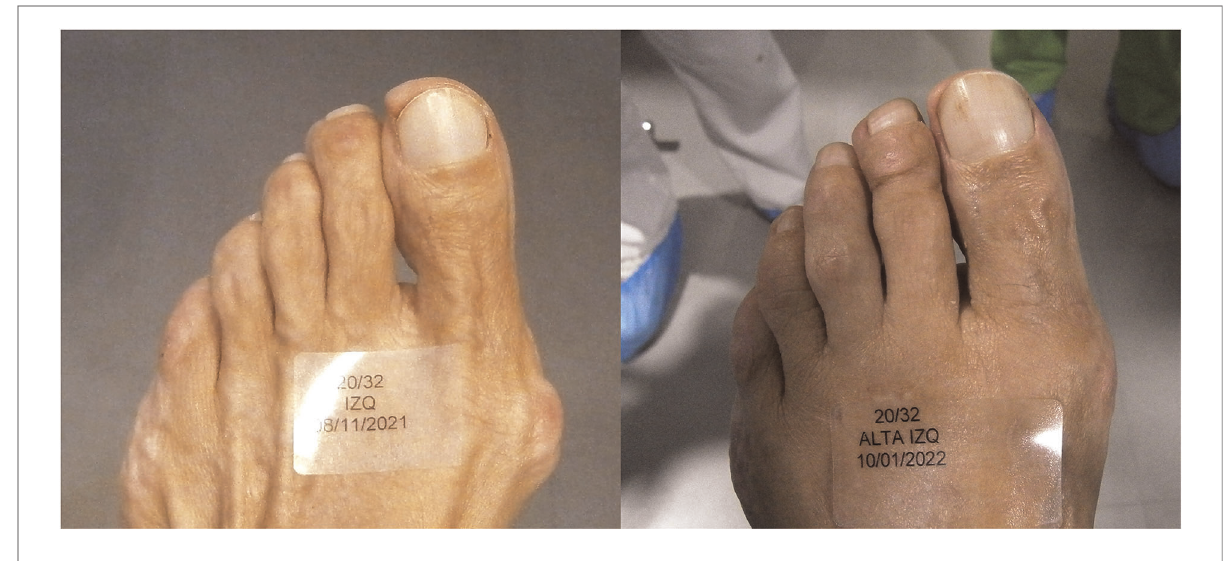
FIGURE 3 Dorsal pre and postoperative images of the left fourth toe.